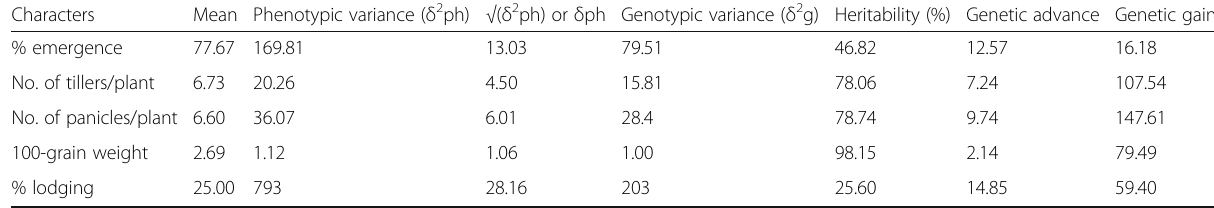
Table 8 Estimate of parameters of variability, heritability, and genetic gain of some characters of the rice varieties in the M 1 generation